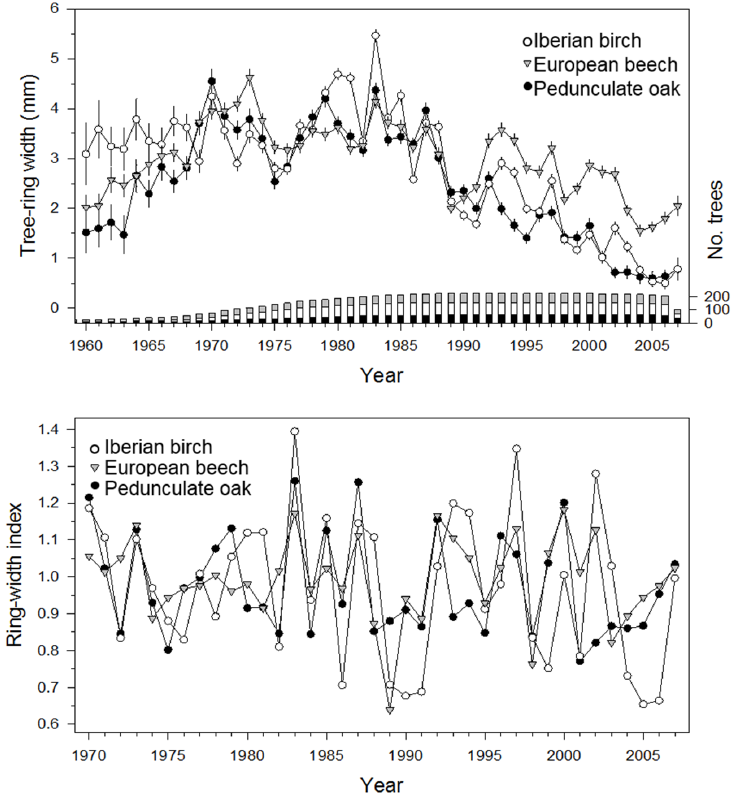
Figure 2. Temporal patterns of tree ‐ ring width ( top ) and ring ‐ width indices (( bottom ), residual chronologies) calculated for the 1977–2007 period and the three species. In the upper plot, the values correspond to the mean ± standard error, and the right y ‐ axis shows the sample size as bars, i.e., the number of trees considered each year.